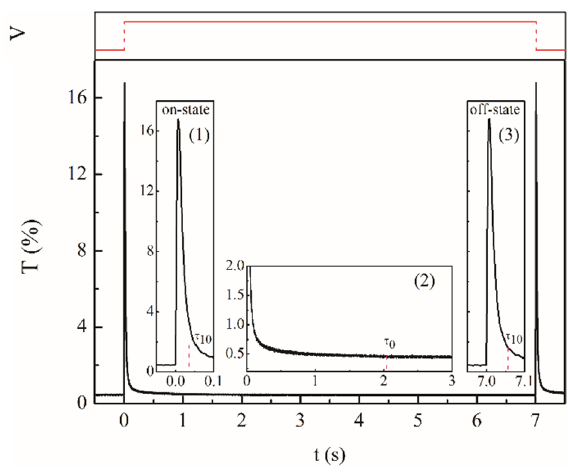
Figure 2. The T - t curves of the PDLC film under DC applied voltage. In insets (1) and (2), the transmittance rose rapidly to the maximum and gradually decreased to the off-state transmittance T 0 when the DC voltage was switched on. In inset (3), when the DC voltage was switched off, the transmittance rose rapidly to the maximum and gradually decreased to T 0